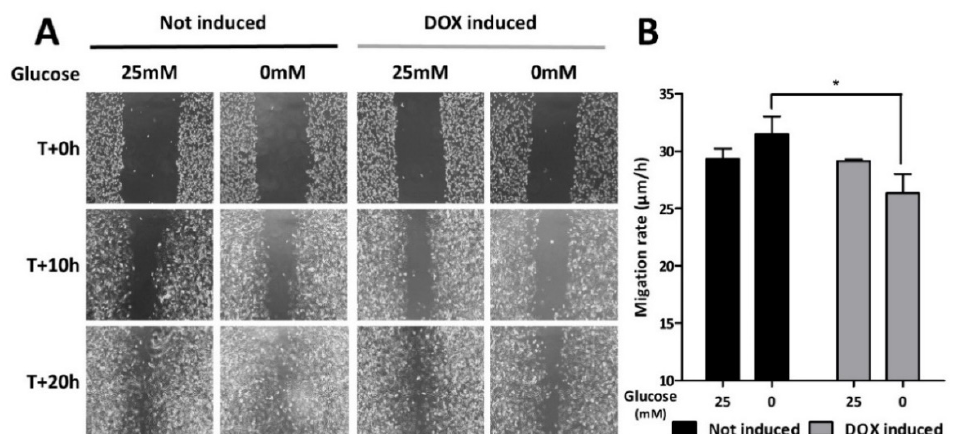
Figure 7. Effect of α 1 DN expression on C6 cells migration.C6-rtTA-AMPK-DN cells treated or not with DOX (2 µg/mL; 24 h) were submitted to glucose deprivation, and cell migration was examined by measuring the kinetics of cell recolonization after mechanically scratching the cell monolayer. Pictures (10× magnification) were taken at the beginning of the experiment (0 h) and every 2 h from +8 h onward over a 12 h period. ( A ) Pictures are representative of four independent experiments, in which every experimental condition was tested in triplicate. ( B ) Histograms illustrate the cell migration kinetic and represent means ± SEM. Statistical analyses were performed by two-way ANOVA followed by Bonferroni’s multiple comparison test (* p < 0.05).